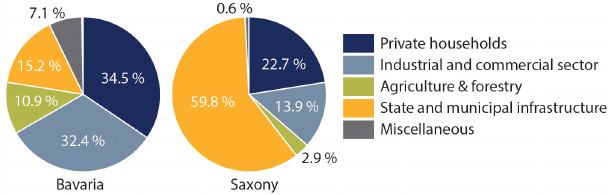
Figure 5. Distribution of the overall direct losses of the flood event in June 2013 according to loss-incurring sectors in the federal states of Bavaria (EUR1.3billion) and Saxony (EUR1.9billion), accord- ing to the Federal Ministry of Finance (BMF,